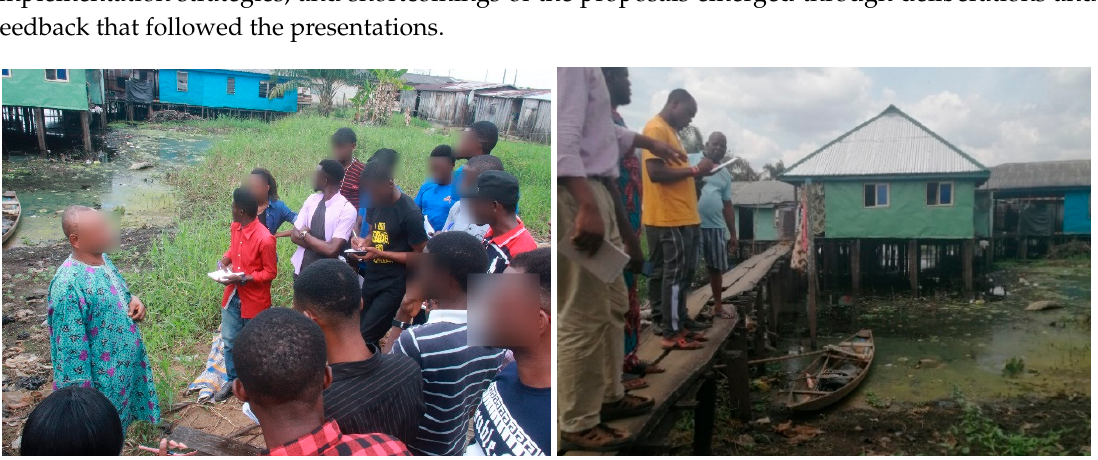
Figure 2. Dwellings on ironwood stilts in Igbokoda, Ondo State, Nigeria.